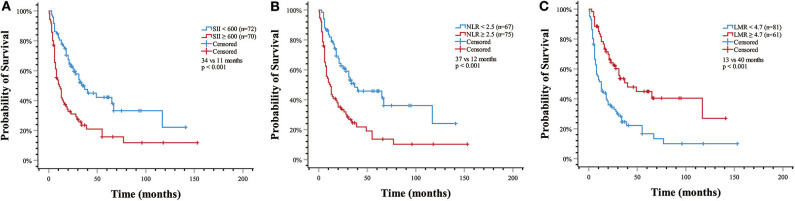
Estimated overall survival with (A) systemic immune-inflammation index (SII) >600 (median OS, 11 vs. 34 months, p < 0.001); (B) neutrophil-to-lymphocyte ratio (NLR) > 2.5 (median OS, 12 vs. 37 months, p < 0.001); (C) lymphocyte-to-monocyte ratio (LMR) > 4.7 (median OS, 40 vs. 13 months, p < 0.001).